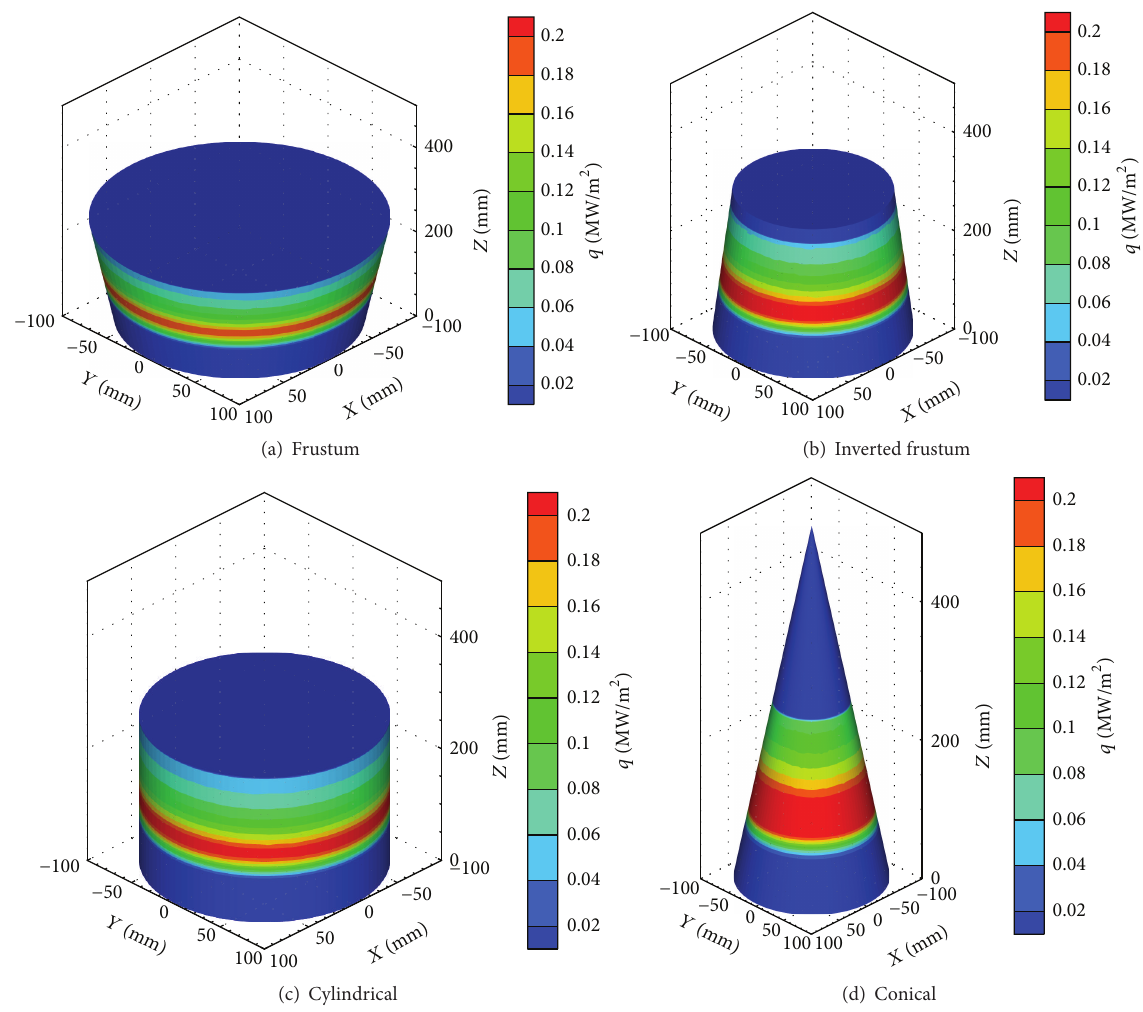
Figure 6: Radiation flux distribution based on equal area-radius